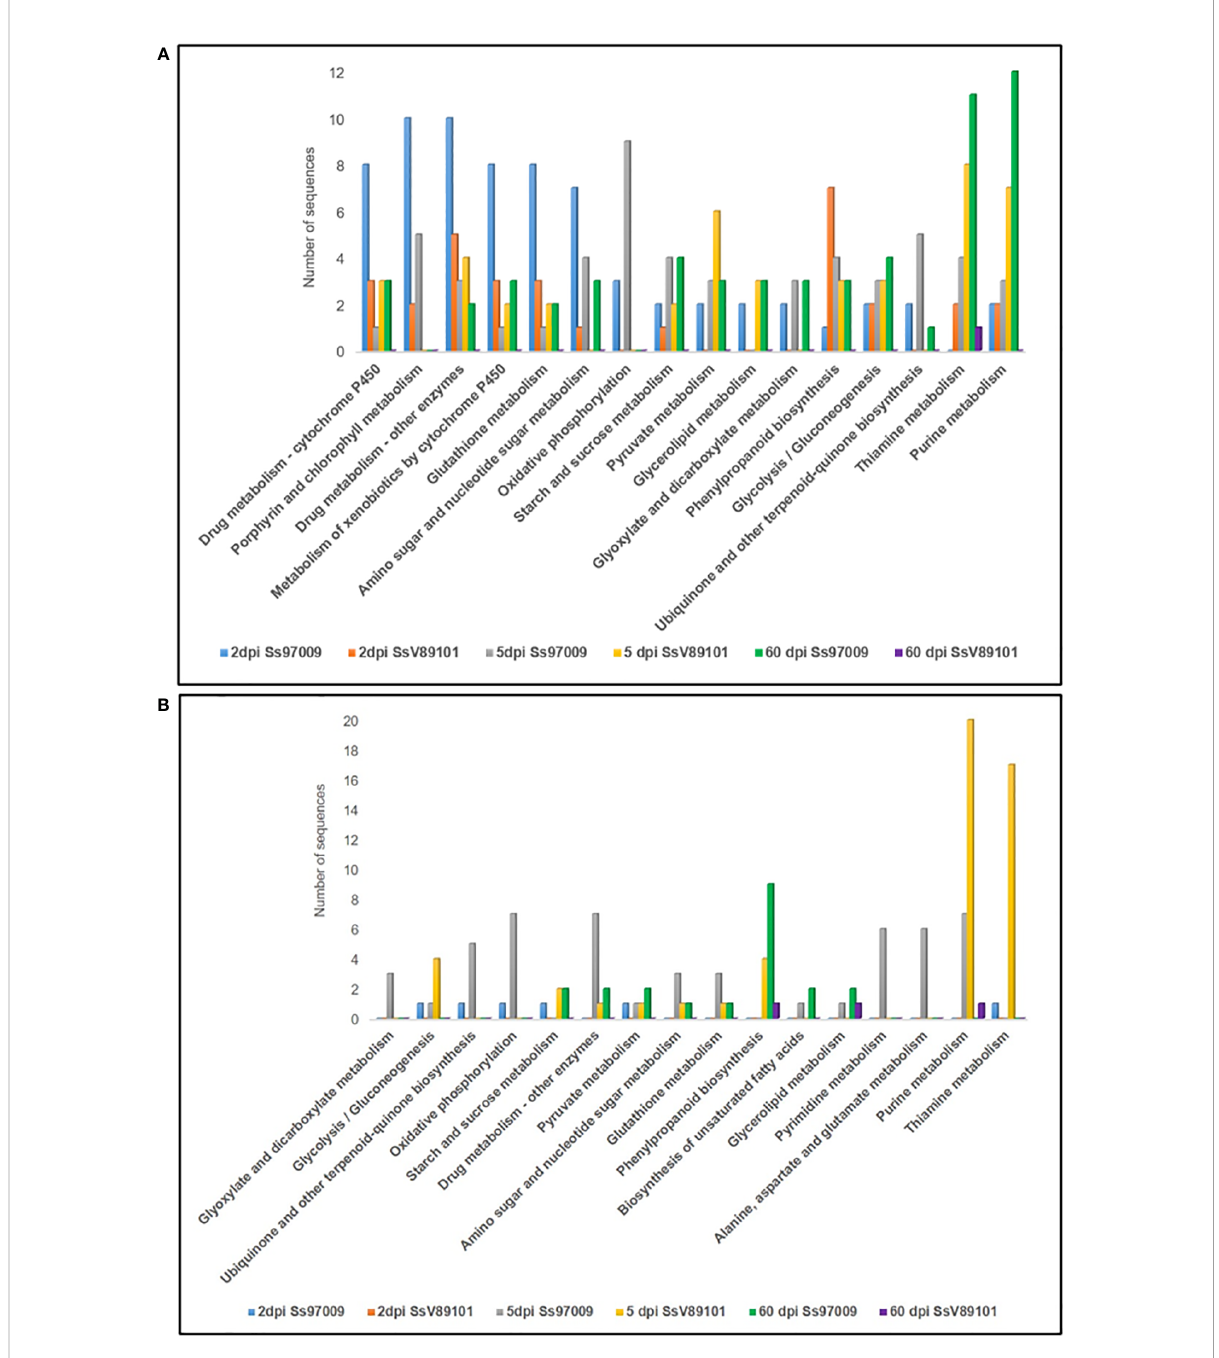
FIGURE 4 Kyoto Encyclopedia of Genes and Genomes (KEGG) pathway annotation of the differentially expressed genes in sugarcane inoculated with the S. scitamineum isolates Ss97009 and SsV89101. Distribution of KEGG pathways in (A) up-regulated and (B) down-regulated DEGs. The x-axis represents the number of genes and the y-axis represents the KEGG